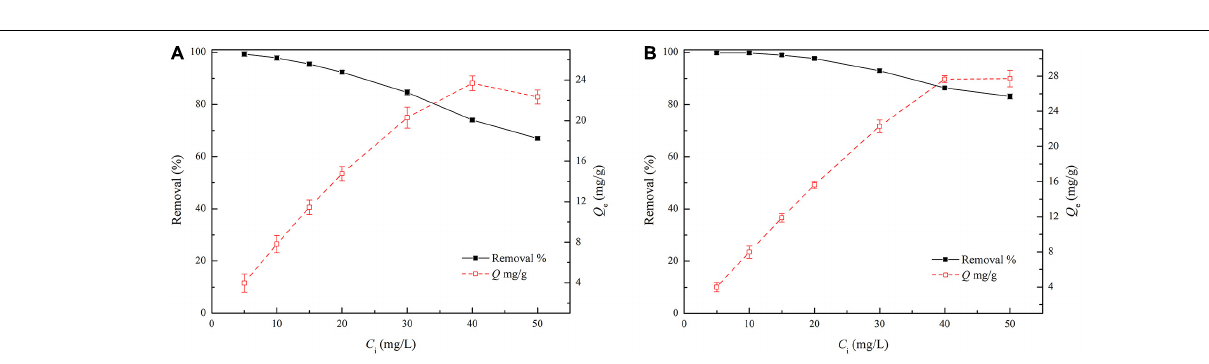
FIGURE 2 | The effect of the biochar dosage on the TC removal.